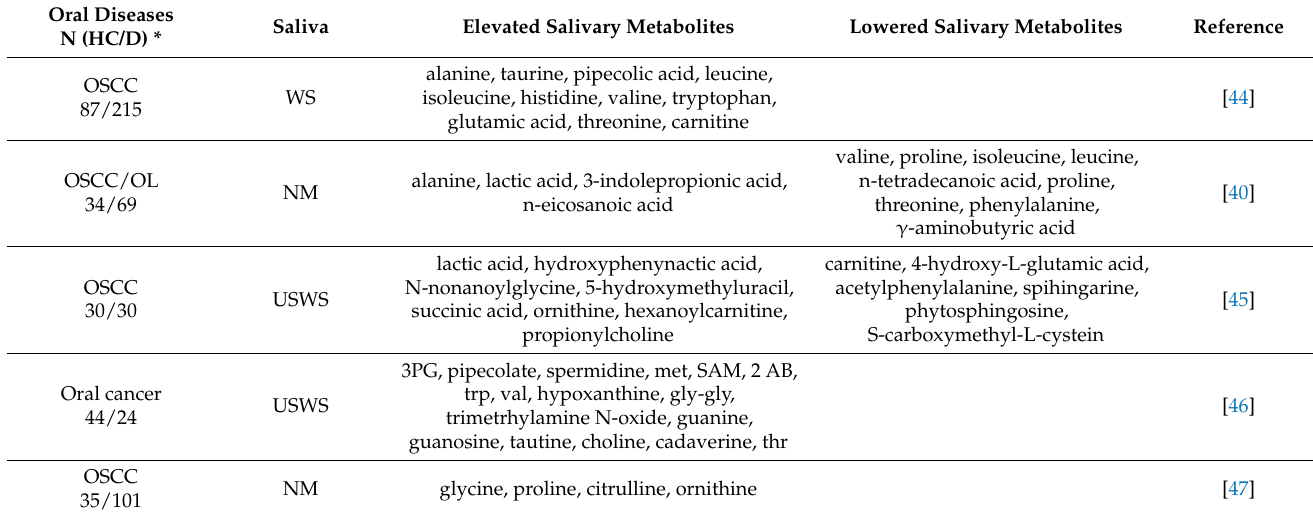
Table 2. Salivary metabolites associated with oral mucosal lesions and oral squamous cell carcinoma